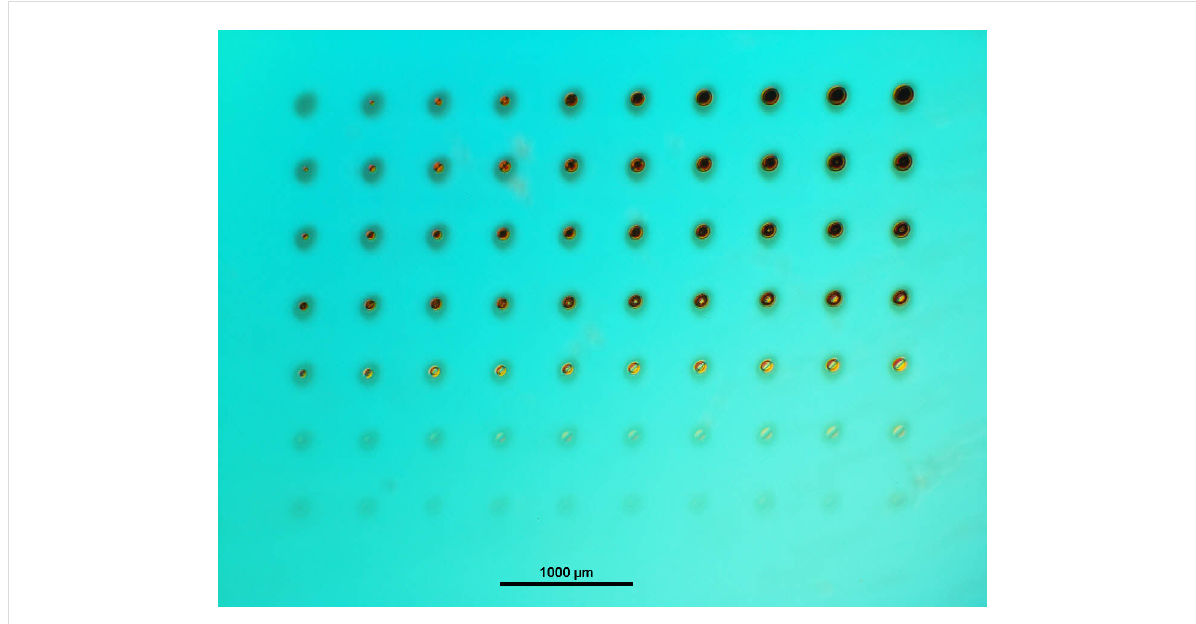
Figure 4: Optical micrographs of fs-laser-treated glass. For each line, the number of pulses per spot, N , is constant. From top to bottom, N amounts to 1000, 300, 100, 30, 10, 3 and 1. The peak laser fluence F varies from 1.24 J/cm 2 (left) to 3.03 J/cm 2 (right).